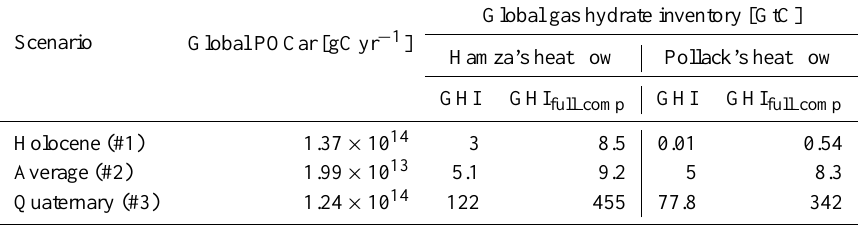
Table 1. Methane hydrate inventory calculated by two different approaches and equations (see the text for details). GHI is the GH formed by methane generated through degradation of organic matter in the GHSZ at normal compaction conditions, while GHI full comp is the global result in complete compacted sediments. The global integrated POCar for each scenario is also shown for